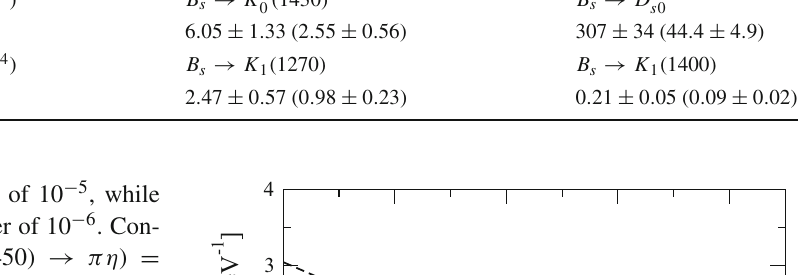
− 4 ) B Theory 1 . 0 ± 0 . 22 (0 . 68 ± 0 . 15)